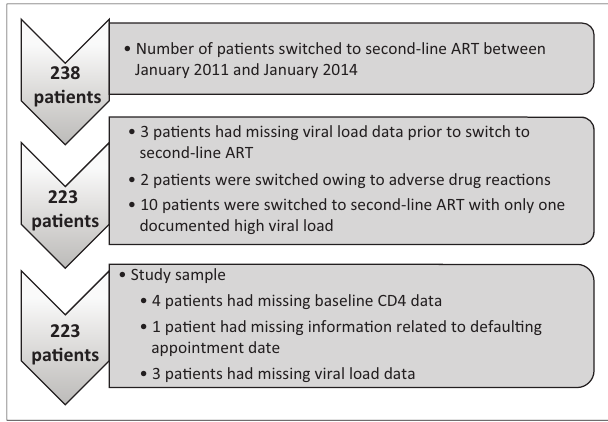
FIGURE 1: Summary of study